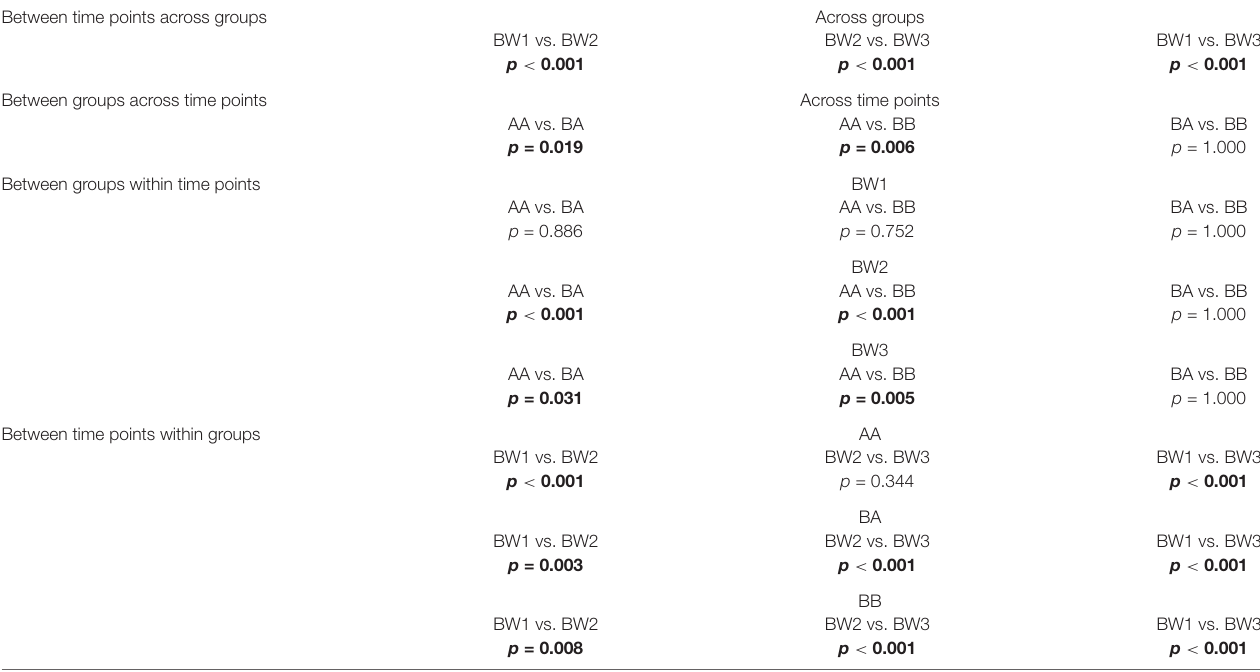
TABLE 2 | Body weight (BW): post hoc comparisons. Between time points across groups Across groups BW1 vs. BW2 BW2 vs. BW3 BW1 vs. BW3 p < 0.001 p < 0.001 p < 0.001 Between groups across time points Across time points AA vs. BA AA vs. BB BA vs. BB p = 0.019 p = 0.006 p = 1.000 Between groups within time points BW1 AA vs.